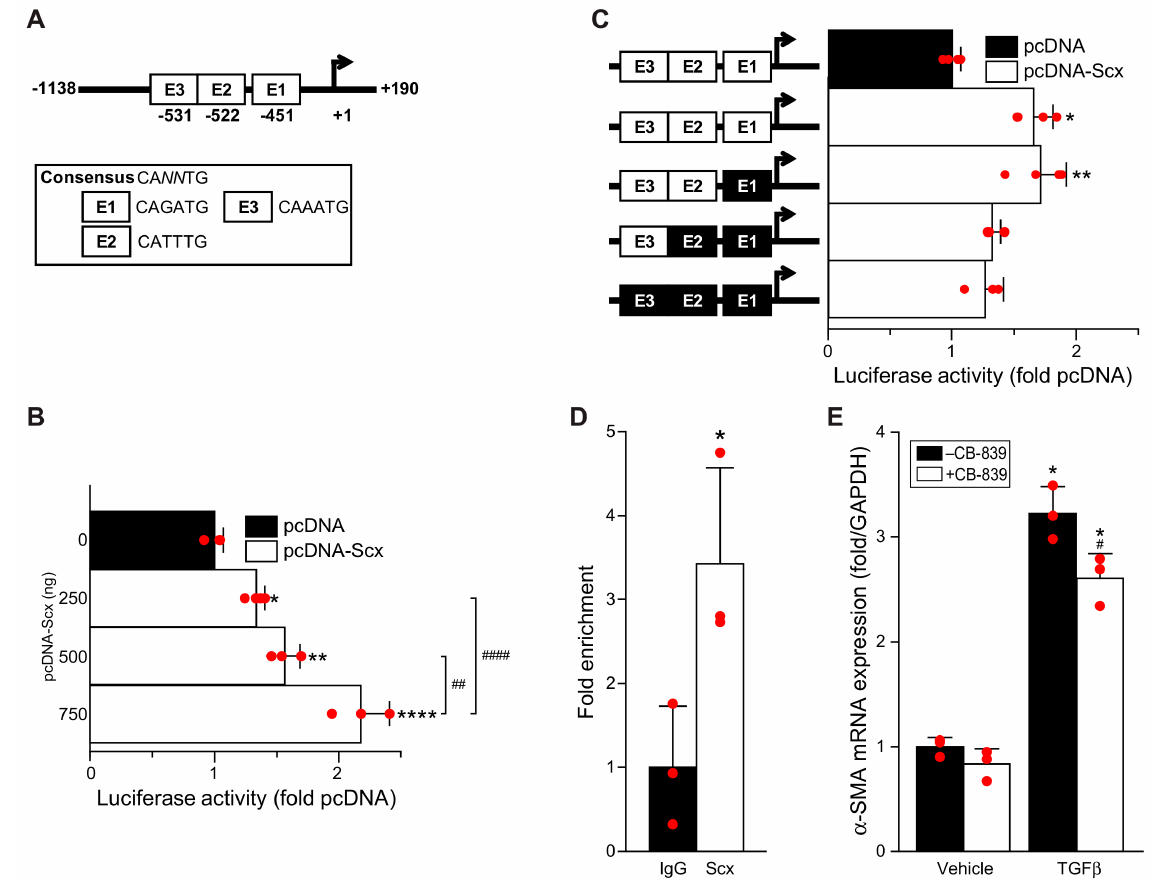
Figure 5. Scleraxis transactivates the human GLS1 gene promoter. ( A ) Schematic depicting the proximal ~1.1 kilobase human GLS1 gene promoter containing three putative E-box sequences (E1–E3); numbers depict distance in nucleotides relative to the transcription start site. ( B ) NIH3T3 fibroblasts were transfected with an hGLS1 promoter luciferase reporter vector plus empty vector (pcDNA) or plus vector encoding scleraxis (pcDNA-Scx) and assayed for luciferase expression. ( C ) NIH3T3 fibroblasts were transfected as in ( B ), with the hGLS1 promoter with either intact (white fill) or sequentially mutated (black fill) E-boxes, and assayed for luciferase activity. ( D ) Chromatin immunoprecipitation was performed in human adult cardiac myofibroblasts using antibodies to scleraxis (Scx) or IgG control and primers spanning the region encompassing E1 to E3, with amplification carried out by qPCR. ( E ) Human cardiac myofibroblasts were treated with 10 ng/mL TGF β and/or 0.3 µ M CB-839 for 24 h, then assayed for α -SMA expression by qPCR. Statistical analysis was by one-way ANOVA with the Tukey post hoc test ( B ) (n = 3–4), or by the Kruskal–Wallis test followed by Dunn’s multiple comparisons (n = 3). * p < 0.05, ** p < 0.01, **** p < 0.0001 versus pcDNA or versus IgG or versus vehicle; # p < 0.05, ## p < 0.01, #### p < 0.0001 versus samples as indicated ( B ) or versus TGF β alone ( E